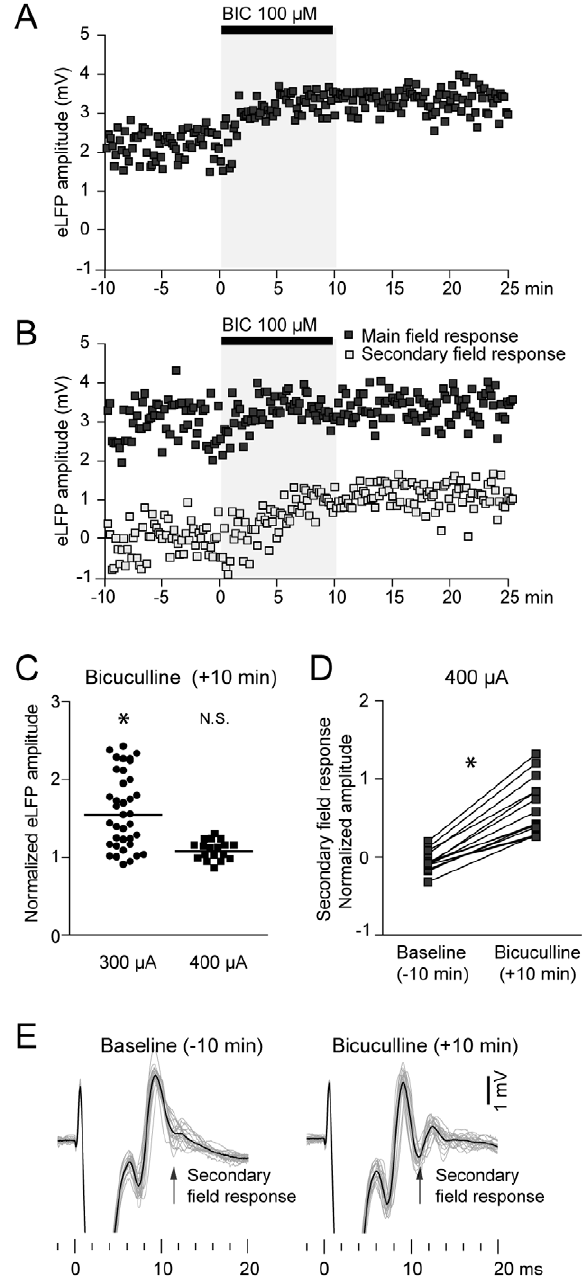
Figure 6. Local administration of a GABA A receptor antagonist increases striatal evoked field potential responses. A. Time course of the evoked field potential amplitude of a representative striatal site tested with 300 m A stimulation intensity. Note a , 50% amplitude increase after 10 minutes of bicuculline infusion. B. Time course of the evoked field potential amplitude of a representative striatal site tested with 400 m A stimulation intensity. Note that the amplitude of the main field response does not signifcantly change after bicuculline infusion. However, a 1 mV secondary field response (open squares) becomes apparent (see traces shown in E). C. Population data of the main field response amplitude after 10 minutes of bicuculline for 300 and 400 m A stimulation intensity. Values are normalized to baseline. * p , 0.0001,Wilcoxon paired test. D. Bicuculline consistently increased or induced the appearance of a secondary field response in all recording sites stimulated at 400 m A that showed a field response during baseline condition (32 6 5%, * p , 0.001 Wilcoxon paired test).